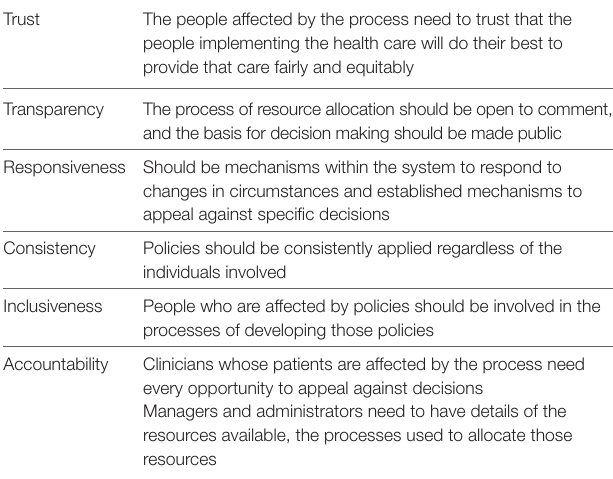
TAbLe 5 | Processes to be applied to the processes of resource allocation for health care. Trust